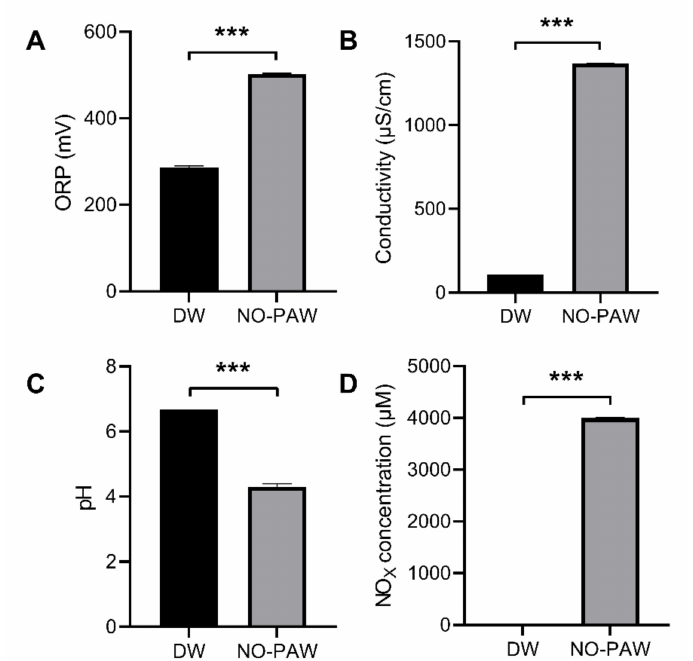
Figure 3. Physicochemical properties of PG-NOW generated using a microwave plasma system. ( A ) ORP, ( B ) conductivity, ( C ) pH, and ( D ) NO X concentration of prepared PG-NOW using mi- crowave plasma system, respectively. *** p < 0.001 vs. Control. The data are represented as the mean ± SD of three identical experiments with three